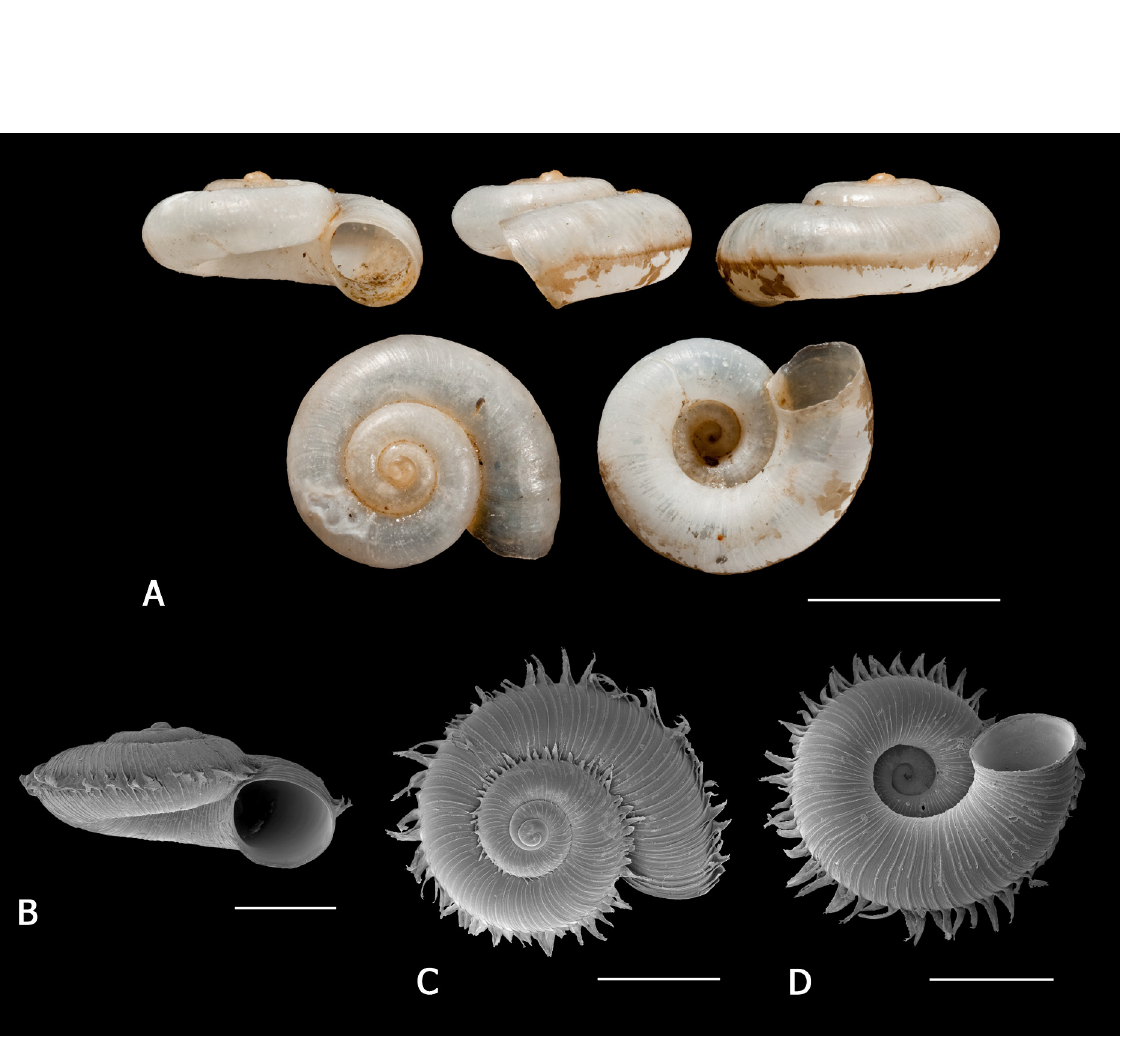
Fig. 6. Chondrocyclus alabastris (Craven, 1880). A . Syntype (NHMUK 1891.3.7.42). B . Aperture view (ELM D16882). C . Dorsal view (ELM W3640). D . Ventral view (ELM W3640). Scale bars: A = 3 mm; B–D = 2